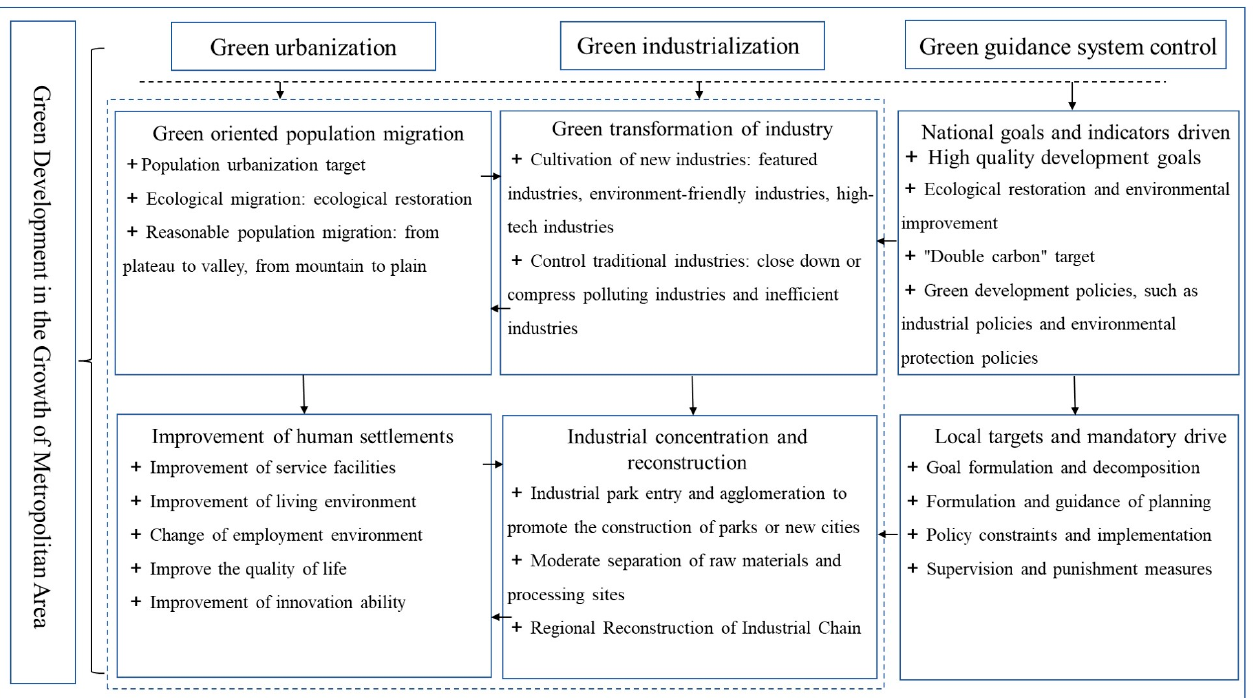
Figure 2. The Green Development Transformation System of the Mutually Reinforcing Two-way Cycle of the XMA.